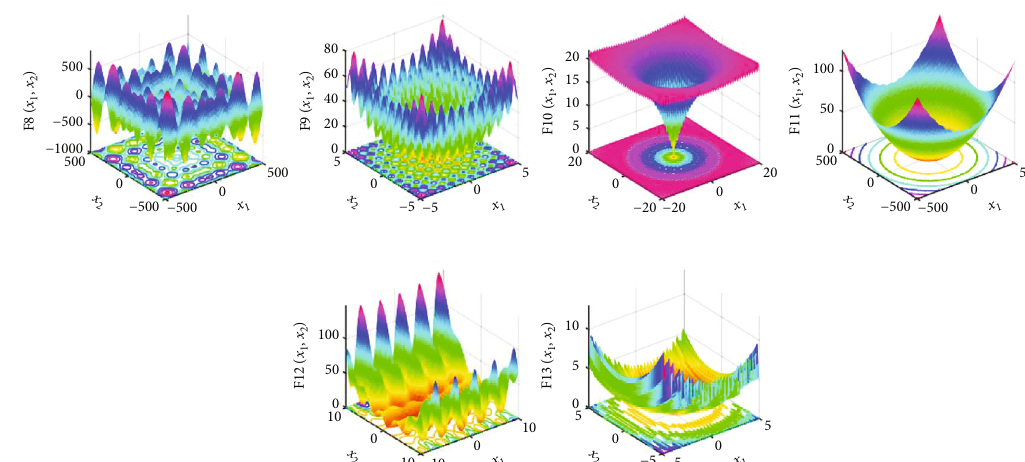
Figure 5: 2-D versions of uni-modal benchmark functions.